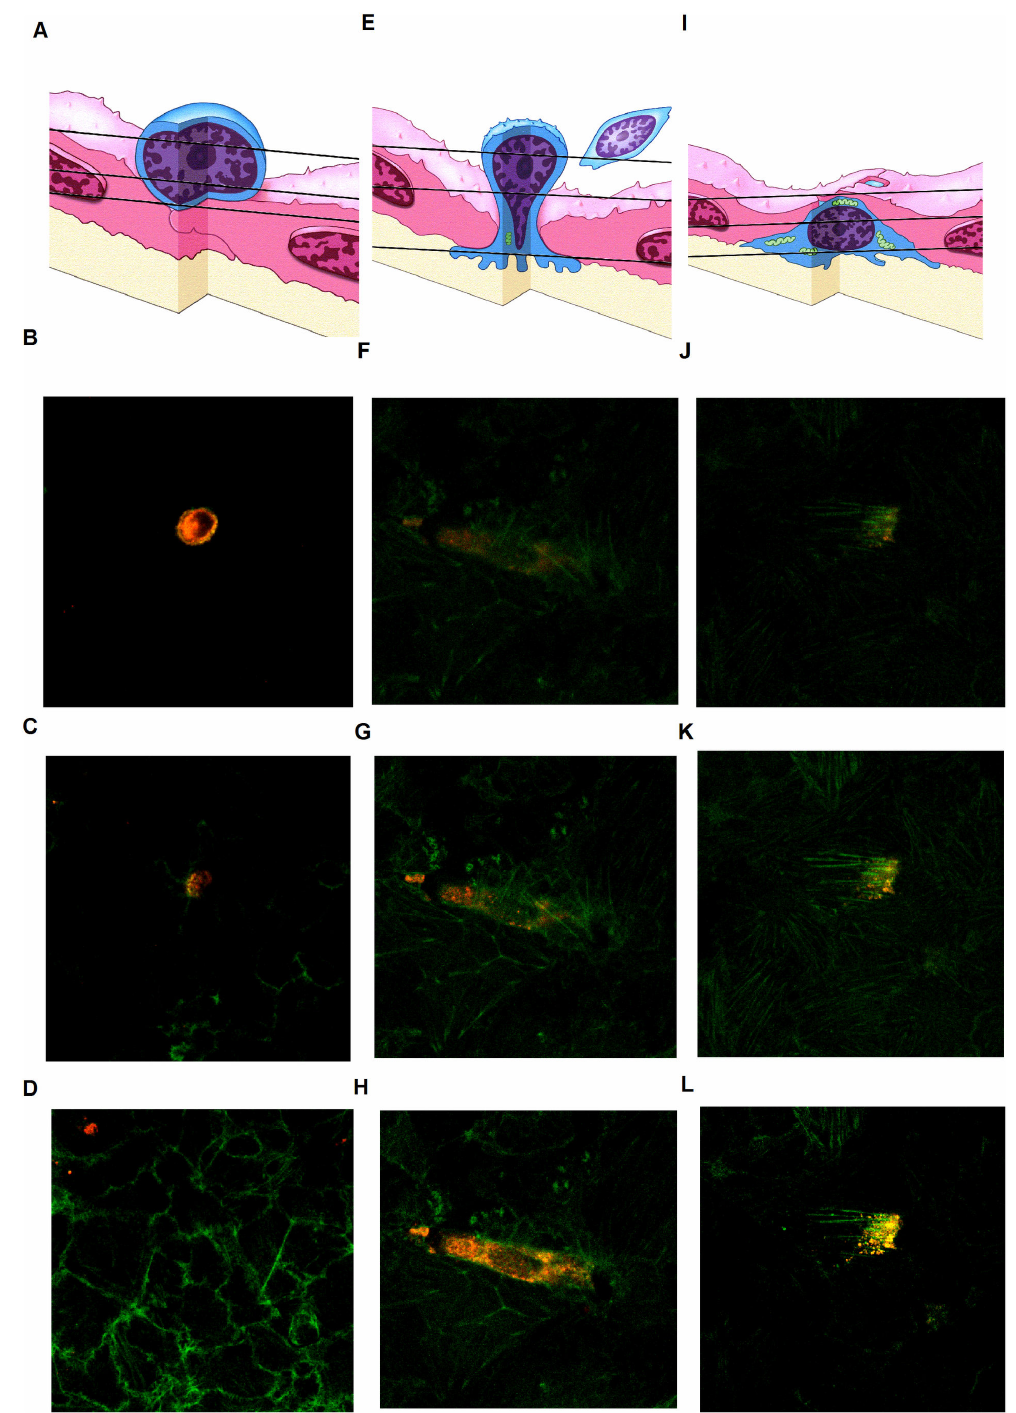
Figure 4. Tumor cell diapedesis through mesothelial cell monolayers. Optical sections obtained by laser scanning confocal microscopy at the focal levels indicated in (A, E, I) identified three major stages of diapedesis: round on top of (A–D), migrating through (E–H), or located underneath (I–L) the mesothelium. (B) Gastric cancer cells with a round shape had filopodial extensions presented in the cytoplasm (arrows). (H) Gastric cancer cells located in mesothelial cell-cell junctions had long spindle and thick bundles of F-actin presented close to cytoplasm (arrows). (K, L) Those that completed diapedesis showed prominent stress fibers distributed loosely in cytoplasm (arrows). doi: 10.1371/journal.pone.0074527.g004 PLOS ONE |